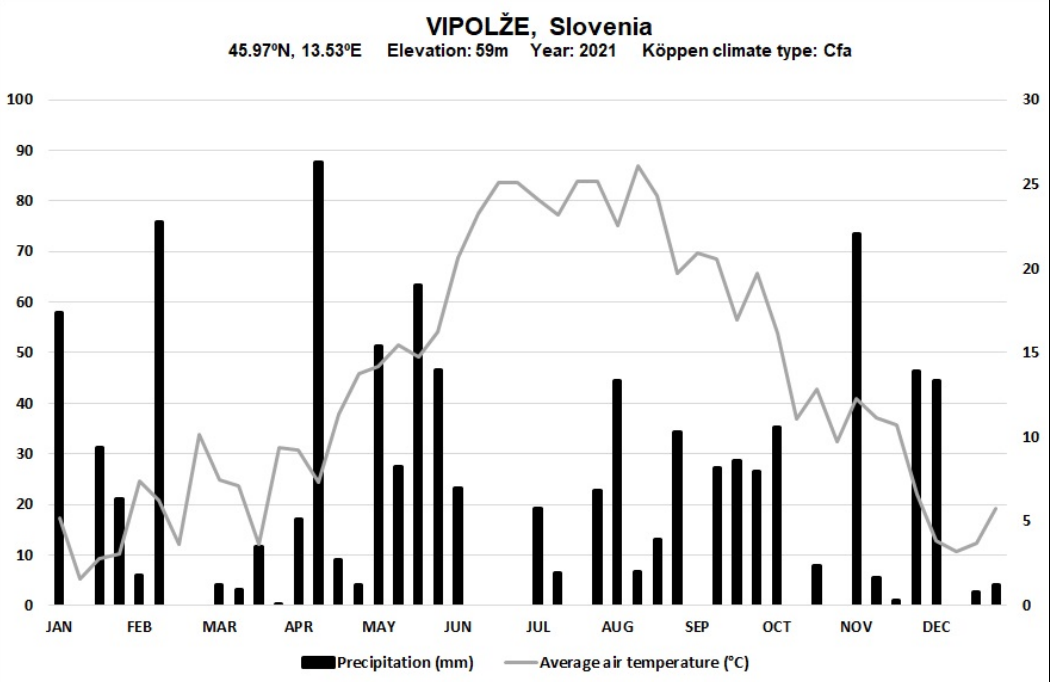
Figure 1. The climatic diagram shows the annual rainfall and air temperature regime. The bars represent the average weekly precipitation (mm), and the line is the average weekly air temperature (°C) at the meteorological station Vipolže (Slovenia) in 2021.